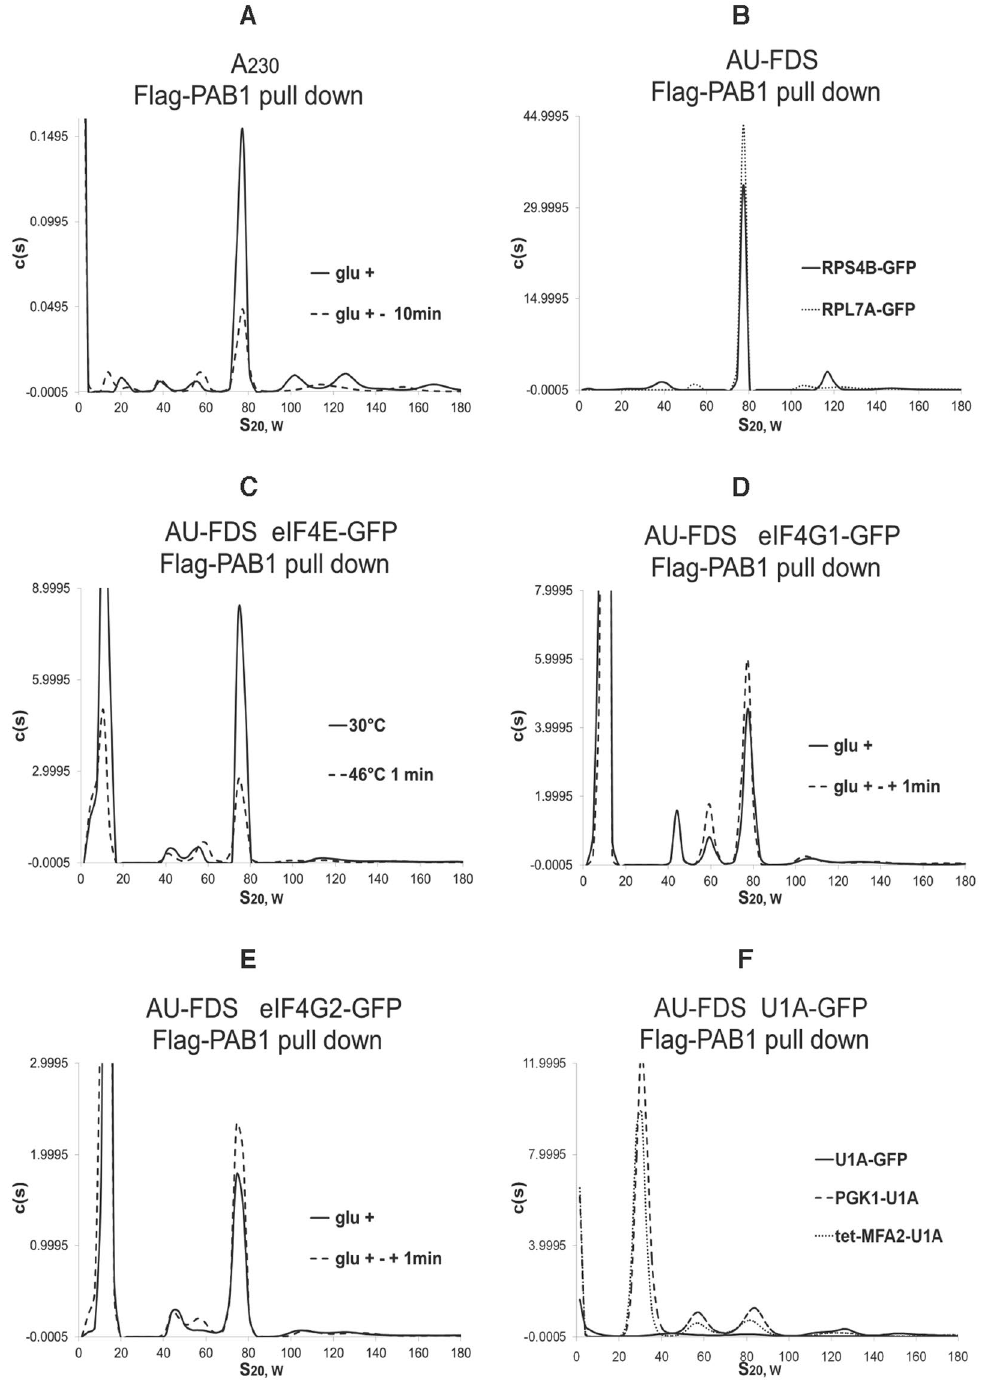
Figure 1. AUC identification of the 57S complex following Flag-PAB1 pull downs. AU-A A230 and AU-FDS analyses on Flag-PAB1 pull downs on cell extracts were done at rotor speeds of 15K rpm. Glucose growth conditions (glu + or 30 °C) are a proxy for steady-state elongation whereas glucose deprivation conditions (glu + − 10 min) or heat shock conditions (46 °C 1 min) result in translational repression 8,25,46 . Initiation conditions were determined by adding glucose back for 1 min to glucose deprived cultures (glc + - + 1 min). Data displayed in the same figure were conducted on the same centrifugation run. It should be noted that differences in the c(s) values (y-axis) between all experiments conducted on different days can not be judged to be significant due to several factors. Cycloheximide was added to all cells prior to cell lysis to prevent ribosomal run-off from mRNA during preparation. ( A ) AU-A 230 analysis of Flag-PAB1 pull down showing glc + versus glc + - ( B – E ). AU-FDS analysis on Flag pull downs on strains carrying GFP tag proteins as indicated under the conditions described. ( F ) AU-FDS analysis on a Flag-PAB1 pull down in strains carrying PGK1-U1A , tet-off- MFA2pG-U1A , or no mRNA co-expressed in cells expressing U1A-GFP